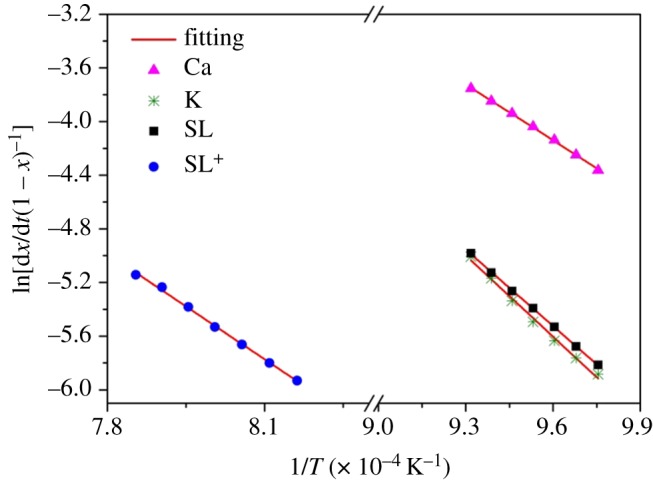
Linear fitting of ln[dx/dt(1 − x)] versus 1/T of samples.